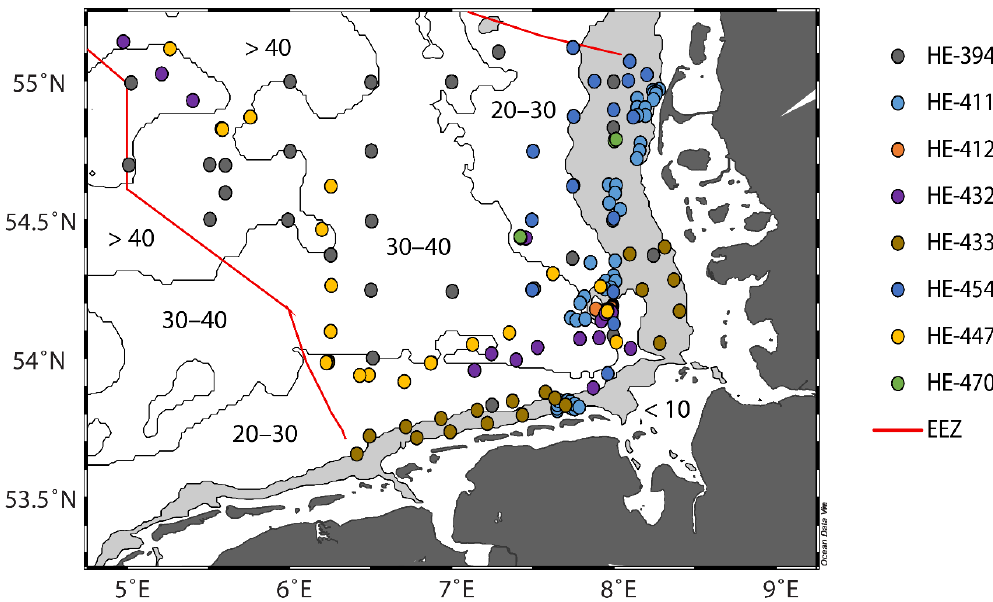
Figure 2. Sampled stations in the German Bight of the southern North Sea. The colors of the circles indicate the individual sampling cruises. The light-grey band indicates the 10–20 m depth interval in which the zone of ballasted flocs is suspected. The red outlines mark the German Exclusive Economic Zone (EEZ).